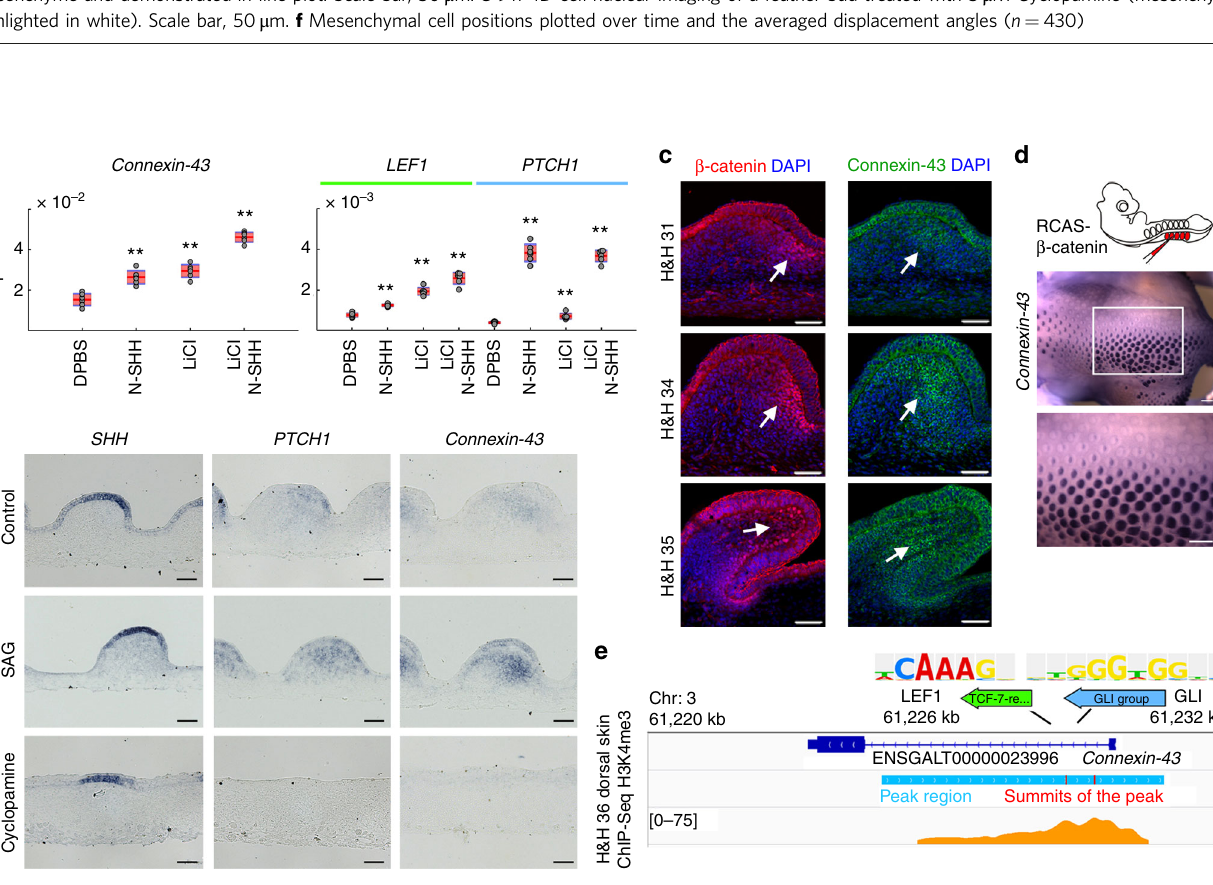
Fig. 7 SHH signaling underlies normal Ca 2 + oscillation and mesenchymal cell migration pattern in feather. a In situ hybridization reveals that SHH is expressed in the posterior – distal epithelium while PTCH1 is enriched in the underlying mesenchyme. An RCAN virus-based GLI reporter demonstrates expansion of the mesenchymal SHH-responding zone anteriorly during feather elongation. Scale bar, 50 μ m. b H&H 31 skins cultured for 4 days in 5 μ M Cyclopamine exhibited dramatic inhibition of feather bud elongation (ellipse, n = 8/8). Scale bars, 500 μ m, 50 μ m. c Expression of opto-cCRAC in feather mesenchyme and cyclic blue light illumination partially rescued the Cyclopamine mediated inhibition of elongation by inducing new feather tips to form ( n = 3/3). The buds with new tips exhibited more elongated morphology (cyan ellipse) than those poorly or not infected ones (magenta ellipse, n = 29 for each group, ** P <0.01, Wilcoxon rank test). Rectangles highlight magni fi ed area. Scale bars, 500 μ m. Customized boxplot: Mean (red)±s.d. (pink), 95% con fi dence interval (violet). Dots denote individual data points. d Virtual sections of 4D Ca 2 + imaging of H&H 34 feather buds treated with 5 μ M Cyclopamine ( n = 2). Scattered Ca 2 + fl uctuations were observed among the cells. Quanti fi cation of F GCaMP6s/F mCherry was conducted for the anterior (cyan rectangle) and posterior (magenta rectangle) mesenchyme and demonstrated in line plot. Scale bar, 50 μ m. e 9h 4D cell nuclear imaging of a feather bud treated with 5 μ M Cyclopamine (mesenchyme highlighted in white). Scale bar, 50 μ m. f Mesenchymal cell positions plotted over time and the averaged displacement angles ( n